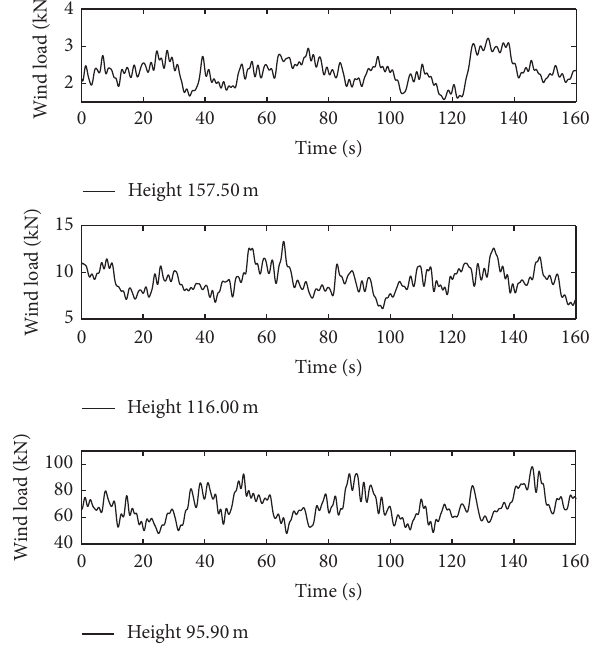
Figure 5: Wind force histories in x direction.